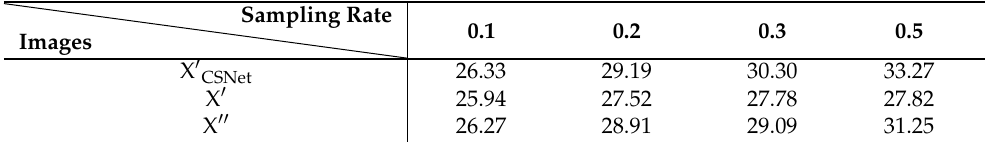
Table 5. Comparing image quality of X (cid:48) CSNet , X (cid:48) and X (cid:48)(cid:48) in terms of PSNR (dB).